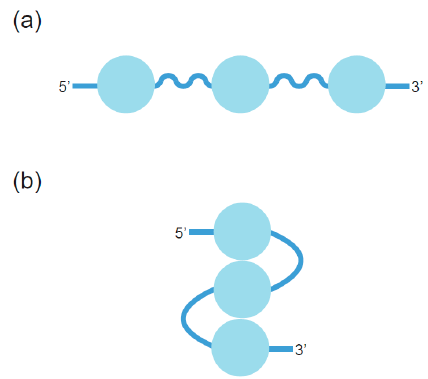
Figure 8. Possible structures of telomeric GQs. ( a ) Beads-on-a-string model in which telomeric GQs do not interact. ( b ) Model in which telomeric GQs stack on one another to form higher-order structures. Blue circles represent GQ structures.